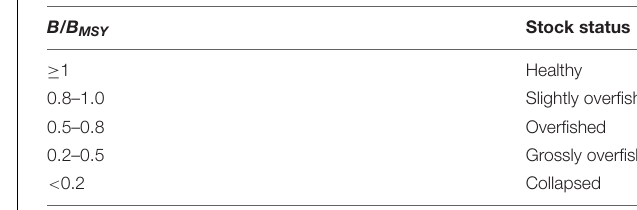
TABLE 5 | Definition of fish stock status, based on B / B MSY in the final year of a time